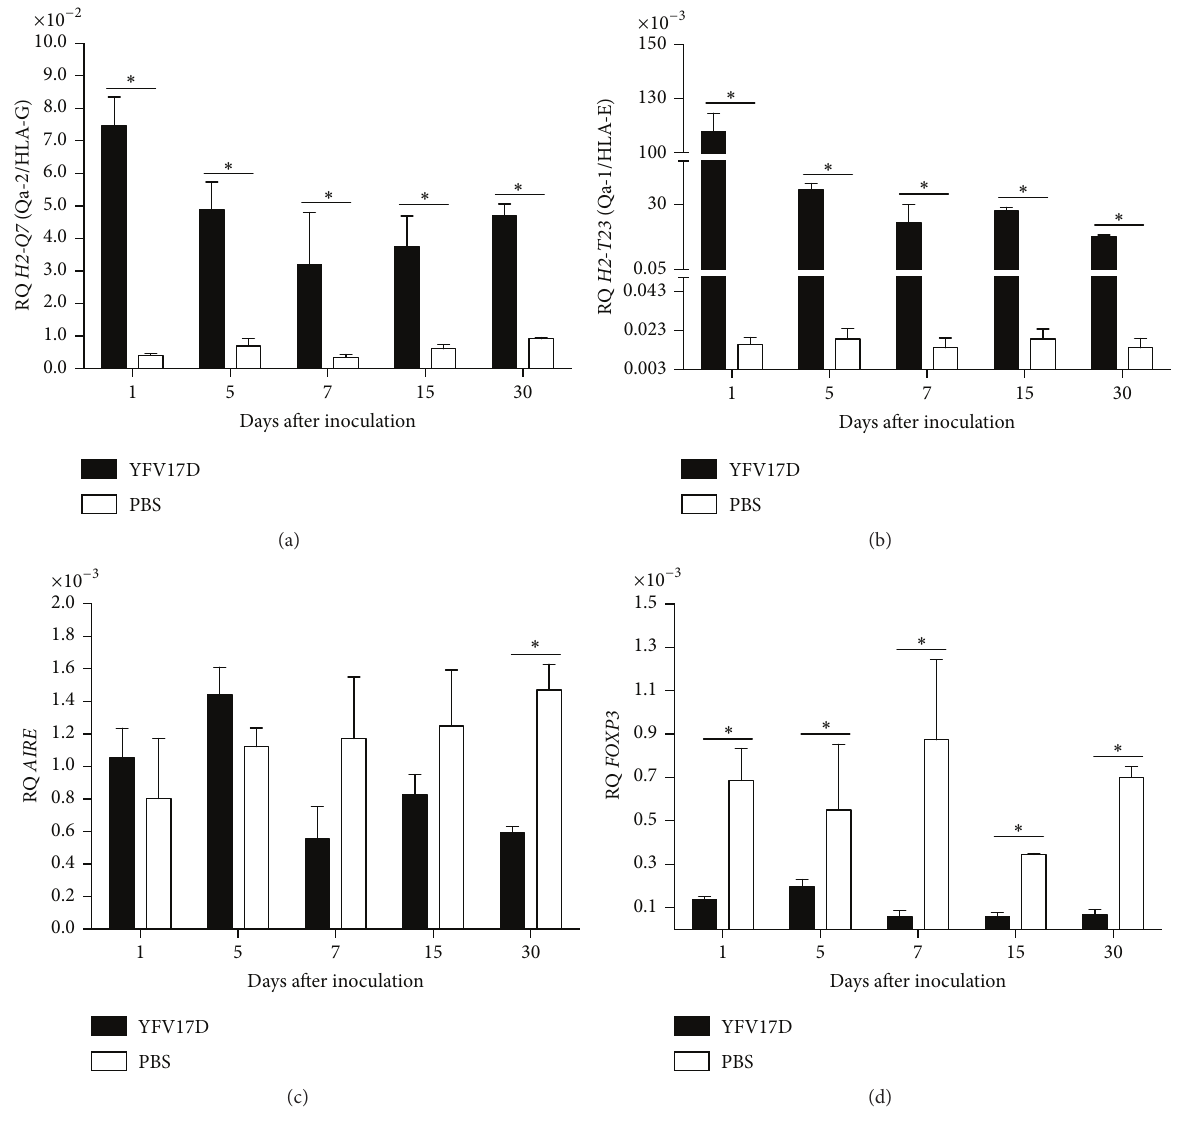
Figure2:Geneexpressionofimmunomodulatorymolecules:(a) H2-Q7 (Qa-2/HLA-G);(b) H2-T23 (Qa-1/HLA-E);(c) AIRE ;and(d) FOXP3 in thymus of C57BL/6 mice inoculated with 10.000 LD 50 of YFV17D or PBS. RQ = relative quantification representative of geometric mean values of 2 −ΔΔ Ct . Tissue samples were obtained in triplicate from different animals for each treatment. Each experiment was independently performed at least three times. Statistical analysis was performed using the nonparametric test Mann-Whitney two-tailed. Values close to the level of significance ( 𝑃 < 0.05 ) are marked with ∗